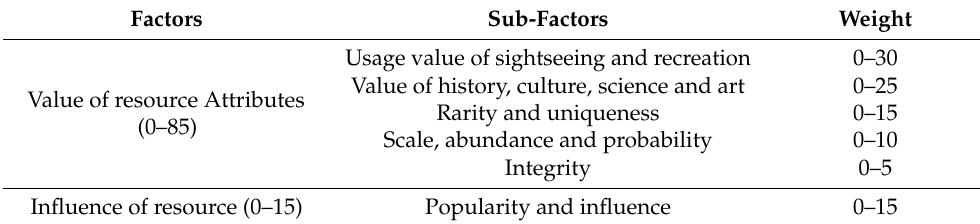
Table 2. Index System of Multi-factor Evaluation on Tourism Resources.